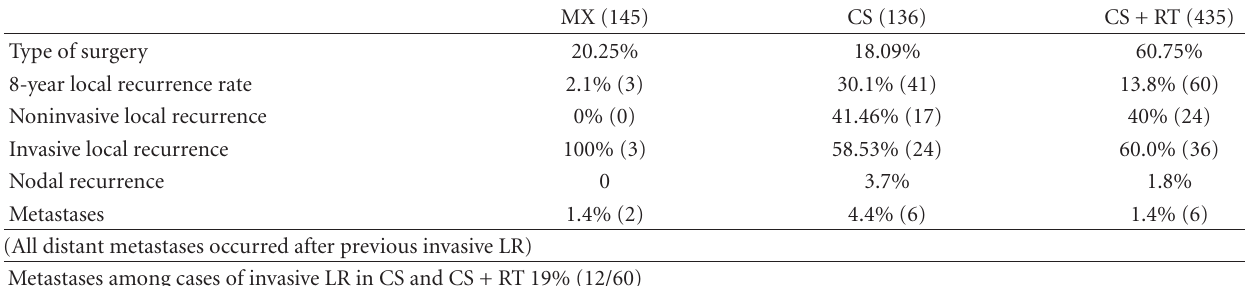
Table 4: 8 years results of conservative and radical treatments in 716